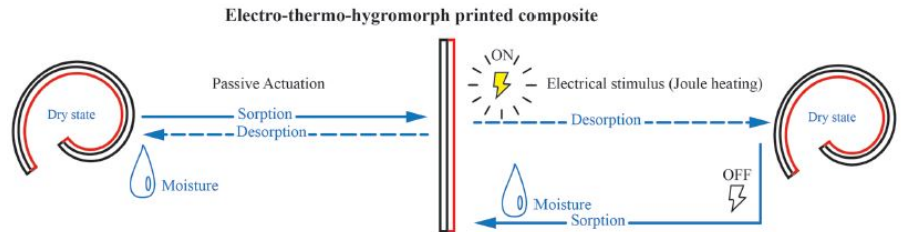
Figure 19. Schematic representation of actuation routes of bilayered structures where the black layer refers to PA66/carbon fibers layer (electrical response), and the red layer represents the PA66 layer (thermo and hygro response) [79]. Reproduced with permission from Wiley-VCH.